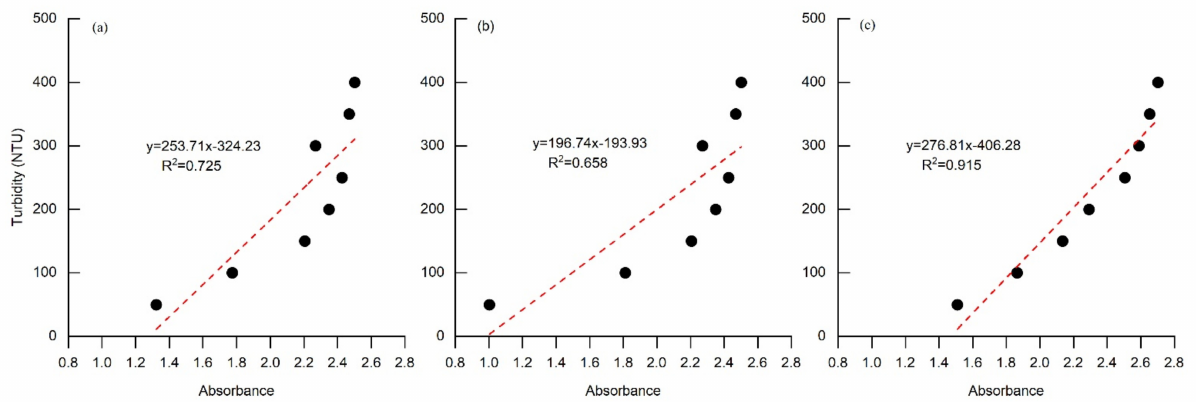
Figure 3. Calibration of turbidity using absorbance at the peak values. ( a ) First peak values of turbidity;